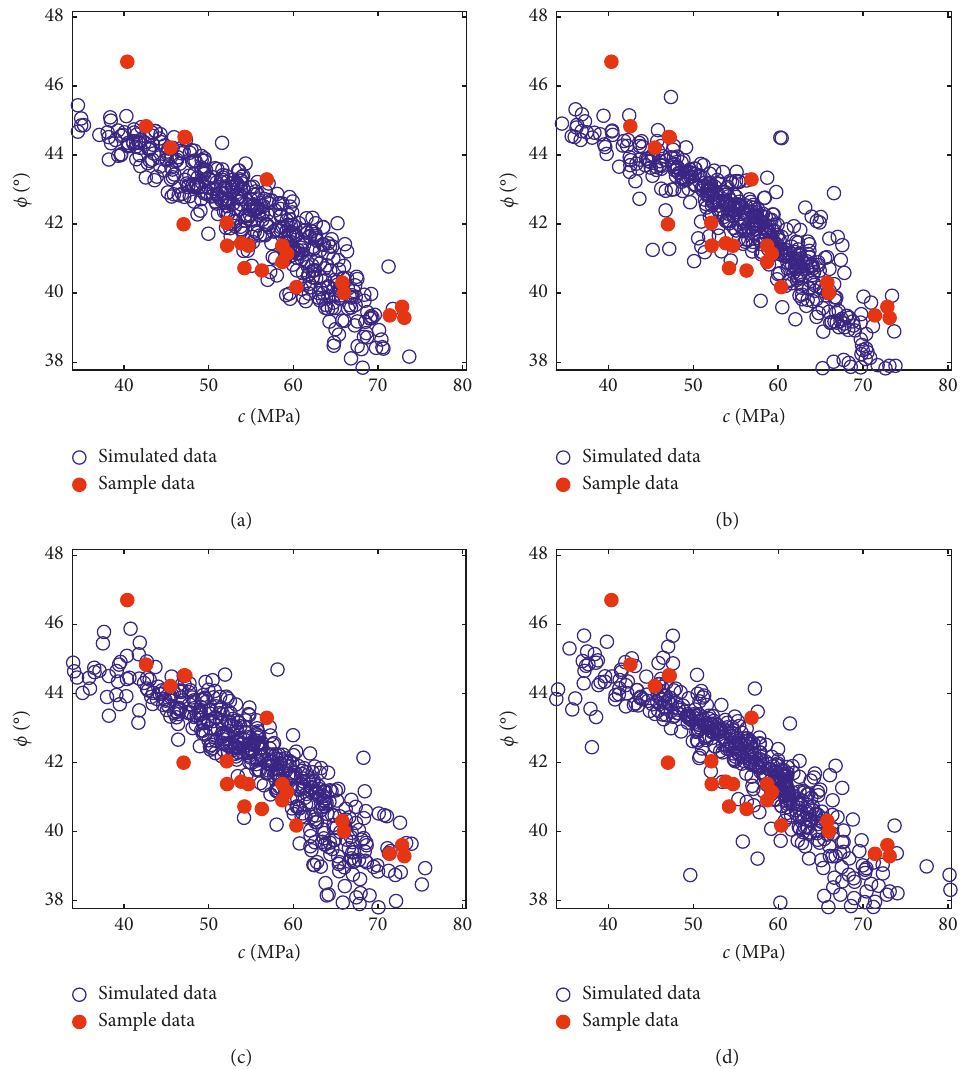
Figure 13: Scatter plots of equivalent samples generated by different copulas coupling Weibull margins. (a) Gaussian copula. (b) Plackett copula. (c) Frank copula. (d) No. 16 copula. Table 8: Statistics and AIC values of equivalent samples associated with four candidate copulas coupling different conventional margins.